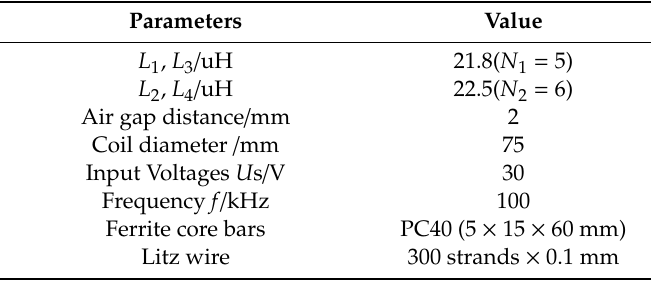
Figure 14. Structures of the power coils. Table 1. Experimental parameters of the